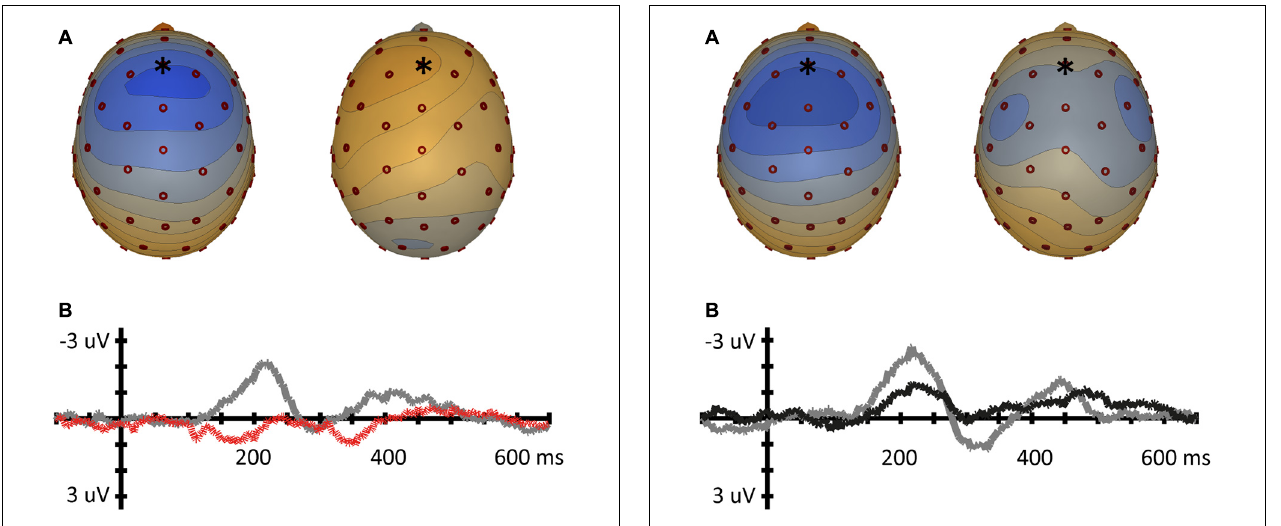
FIGURE 5 | Mismatch negativity for the Labiality contrast (vowel pair /e-ø/). (A) Topographic voltage plots of the MMN at the average MMN peak latency for both conditions (left: [ø]/e/, 219 ms; right [e]/ø/, 216 ms). Blue in topoplot indicates negative potential ( µ V), red indicates positive potential, electrode Fz is indicated with an asterisk. (B) MMN waveforms for the Fz electrode [ø]/e/ (gray) and [e]/ø/